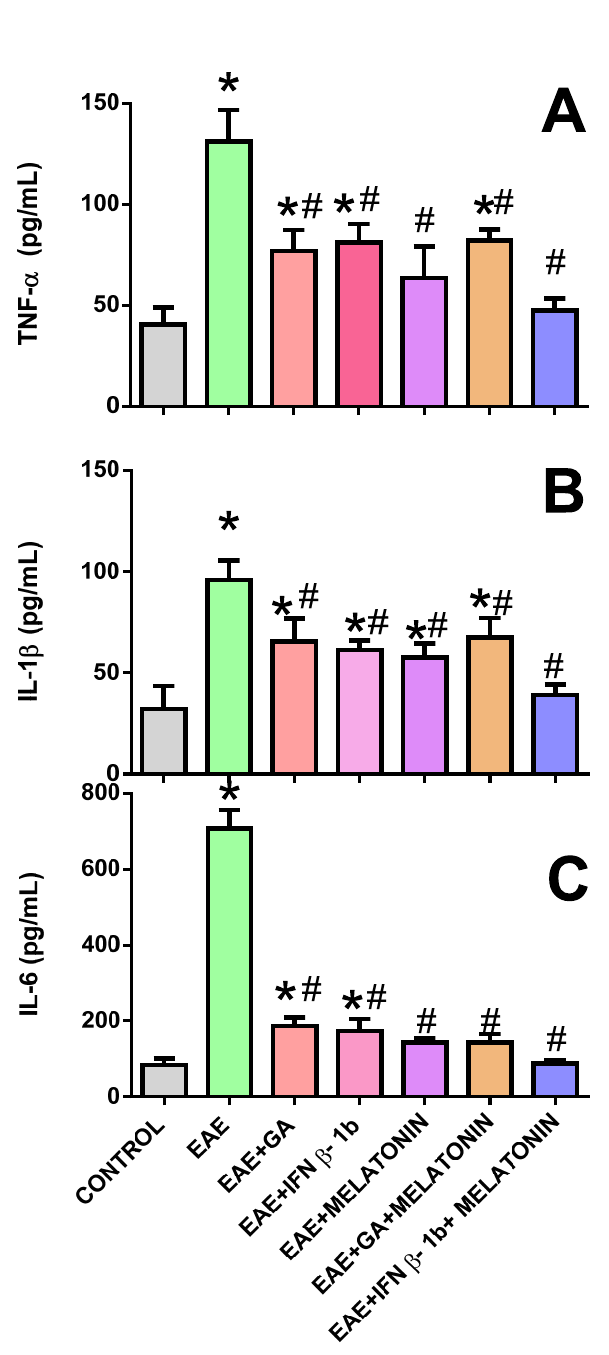
Figure 3. Plasma concentrations of TNF α ( A ), IL1 β , ( B ), and IL6 ( C ) from rats immunized as indicated above and subjected to the indicated treatments. * indicates a significant difference from the control group ( p < 0.05); # indicates a significant difference from the EAE group ( p < 0.05).